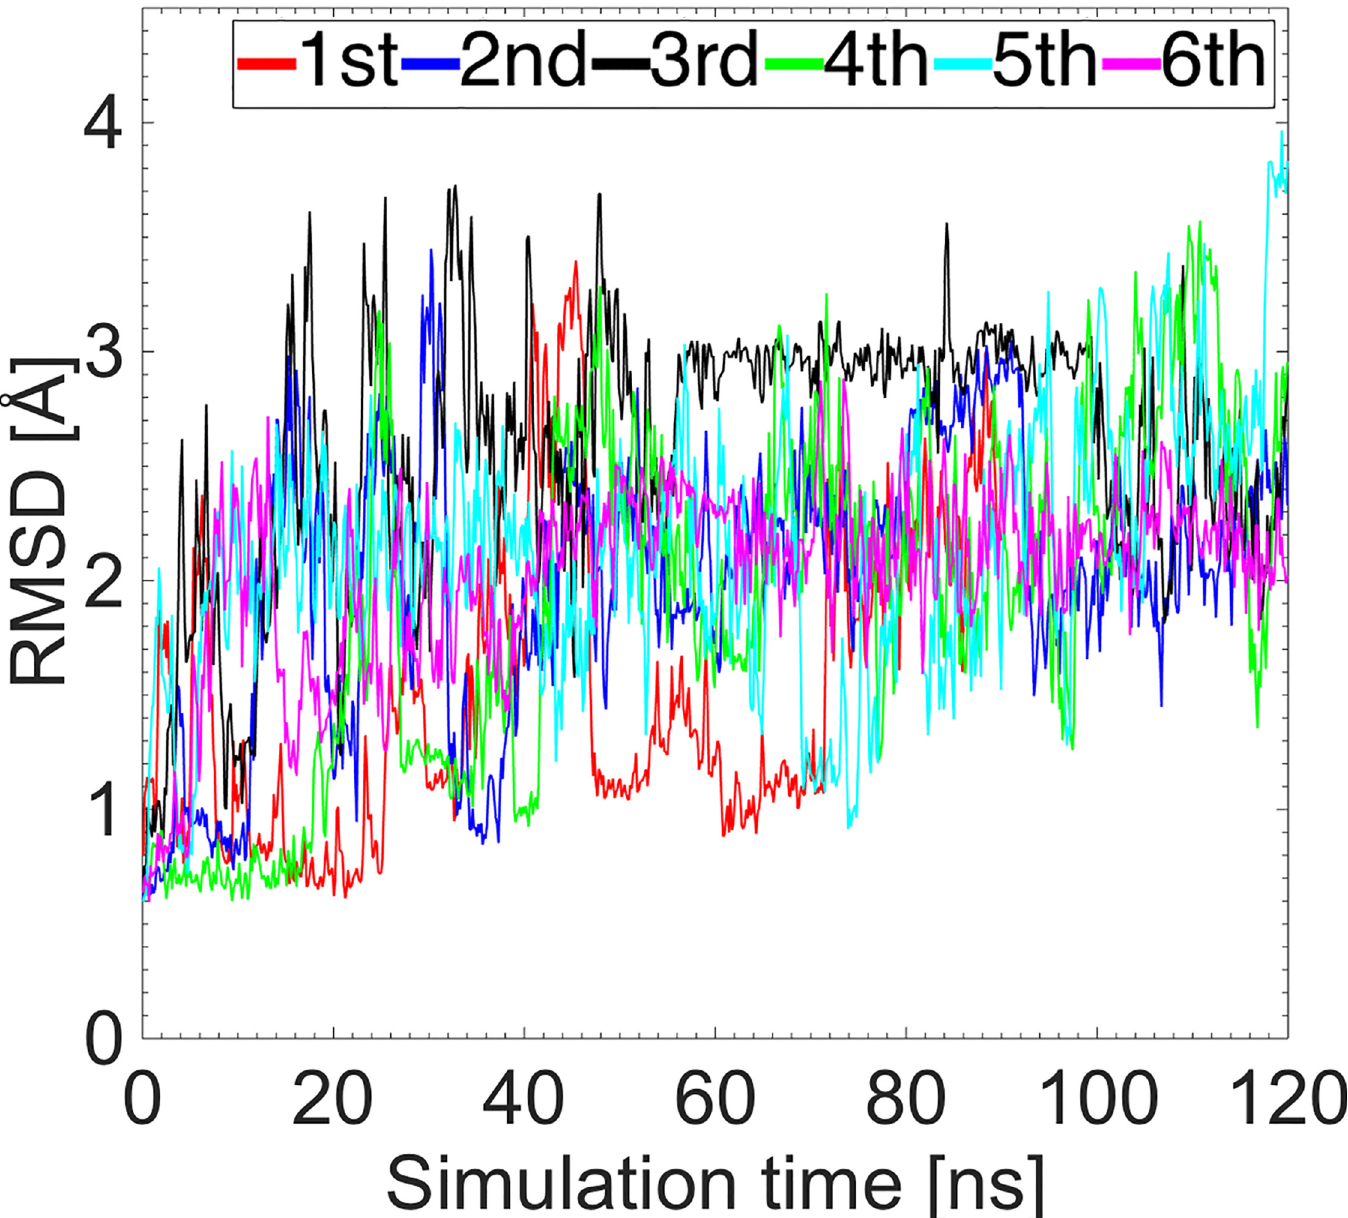
Fig 2. RMSDs of six MD simulations of insulin. The first five MD simulations have a duration of 120 ns, while the sixth one 90 ns. The RMSDs are given with respect to the crystal structure